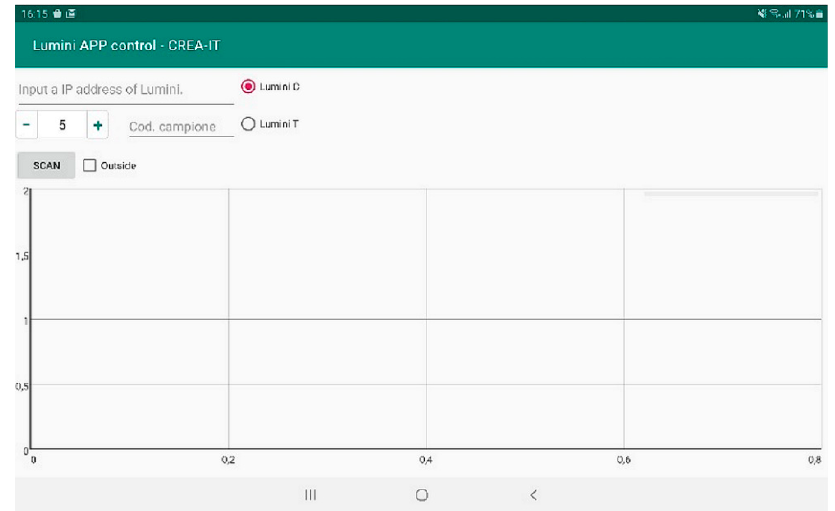
Figure 3. Screenshot of the Lumini app control CREA-IT for spectrophotometric acquisitions of EVOO samples.